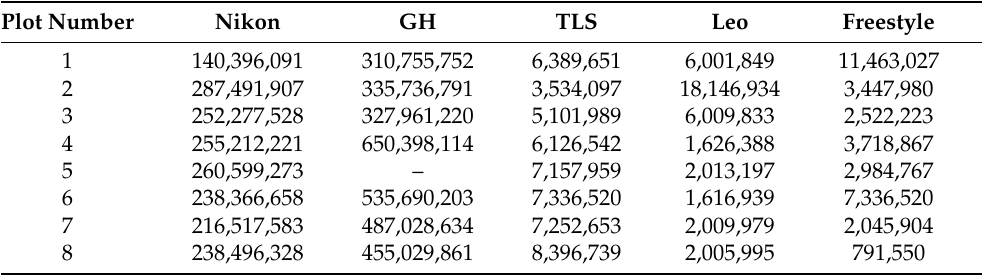
Table 10. Final point cloud sizes as produced by different instrumentations, cropped to the research plot. Due to misalignment, GH measurements for plot 5 were discarded.